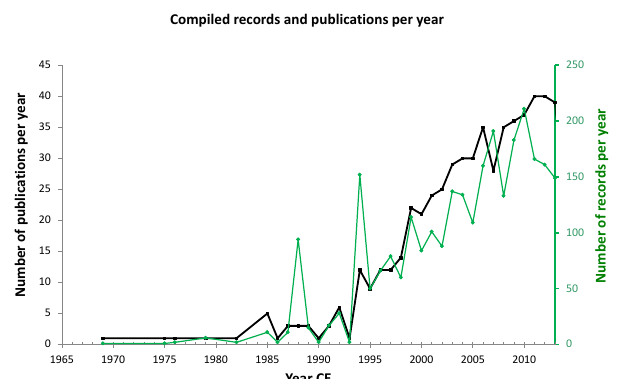
Figure 3. Map indicating the position of archives with different symbols representing the type of archive for dated δ 18 O (top) δ 13 C (center) and δ D records (bottom) available on the online portal. Note that these maps only display the location of dated records, and stack and multi-sites composite records are not